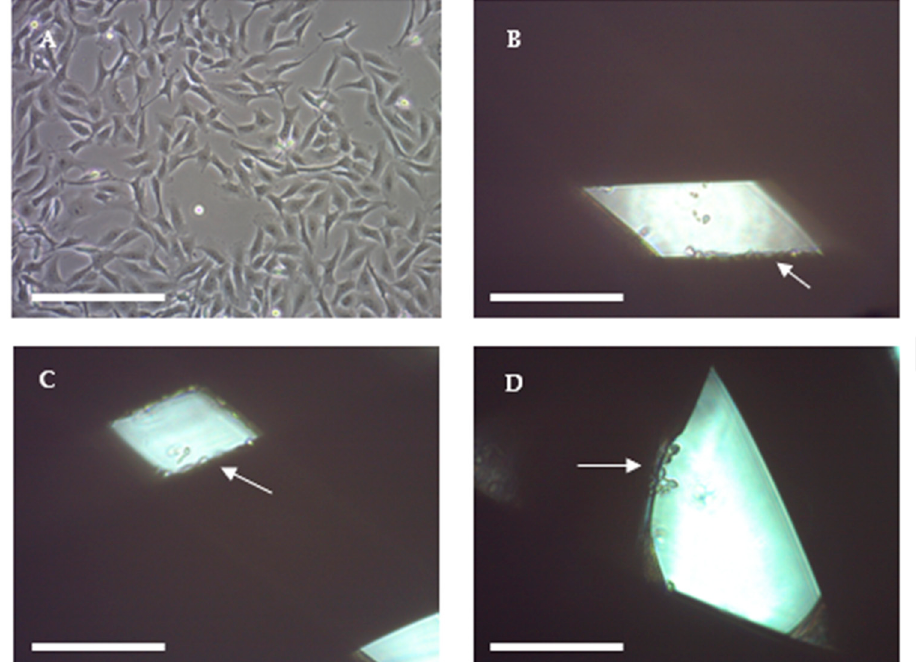
Figure 5. Optical microscope images of MDA-MB-231 cells attached to scaffold walls. ( A ) MDA-MB-231 cells on a 2D cell culture. ( B ) Cells attached to the SS1 configuration scaffold. ( C ) MDA-MB-231 cells attached to scaffold configuration 18. ( D ) Cells attached to scaffold configuration 25. White arrows indicate cells adhered to PLA filaments. Images from optical microscopy 100×. Scale bar: 0.25 mm